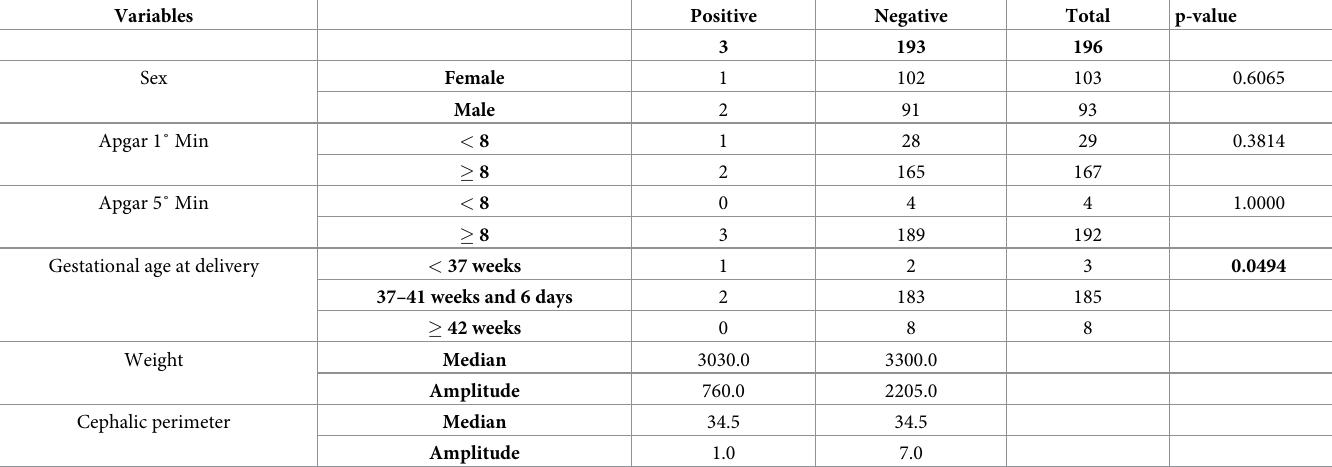
Table 3. Relationship for umbilical cord RT-PCR and newborn variables.